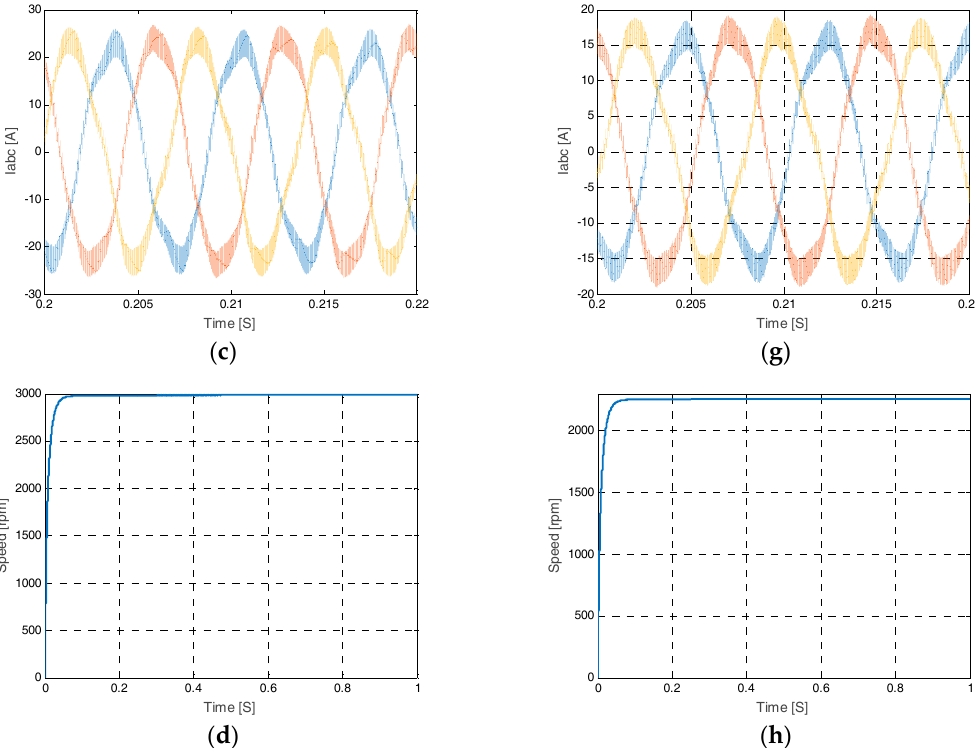
Figure 10. Simulation results of FLC-based P&O algorithm. Operating at 25 °C and 1000 W/m 2 conditions; ( a ) P - V curve of PV array, ( b ) the PV array’s current and voltage, ( c ) Stator currents, ( d ) Motor speed, operating at 25 °C and 500 W/m 2 conditions; ( e ) the PV array’s P - V curve, ( f ) the parameters ( I , V ) of the PV array, ( g ) Stator currents, ( h ) Motor speed.